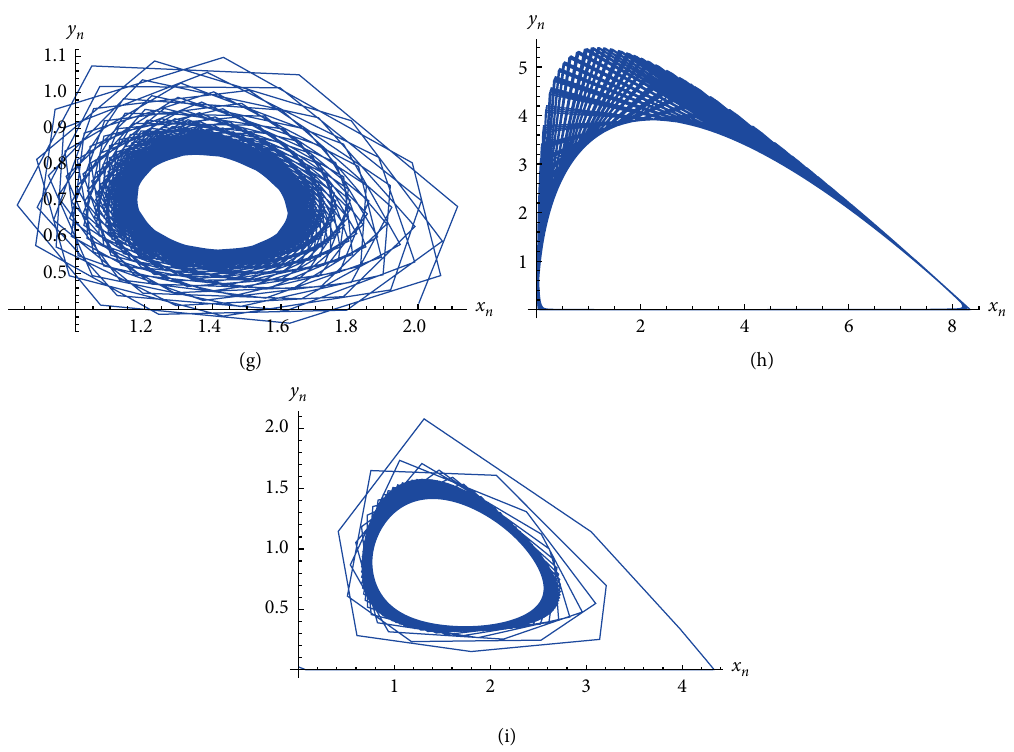
Figure 3: Phase portraits of the model (8). (a) with (0.001, 0.002). (e) 𝜁 2 = 3.6